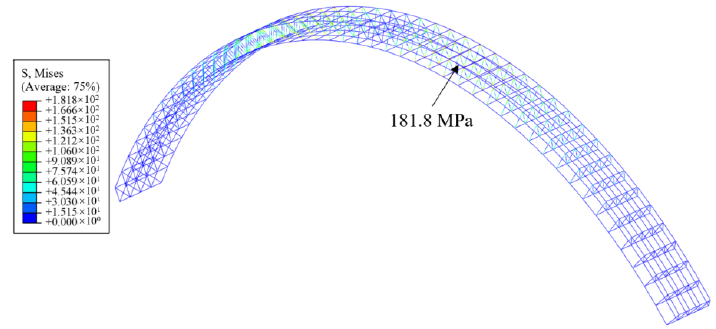
Figure 18. Mises stress nephogram of spatial reticulated grid.